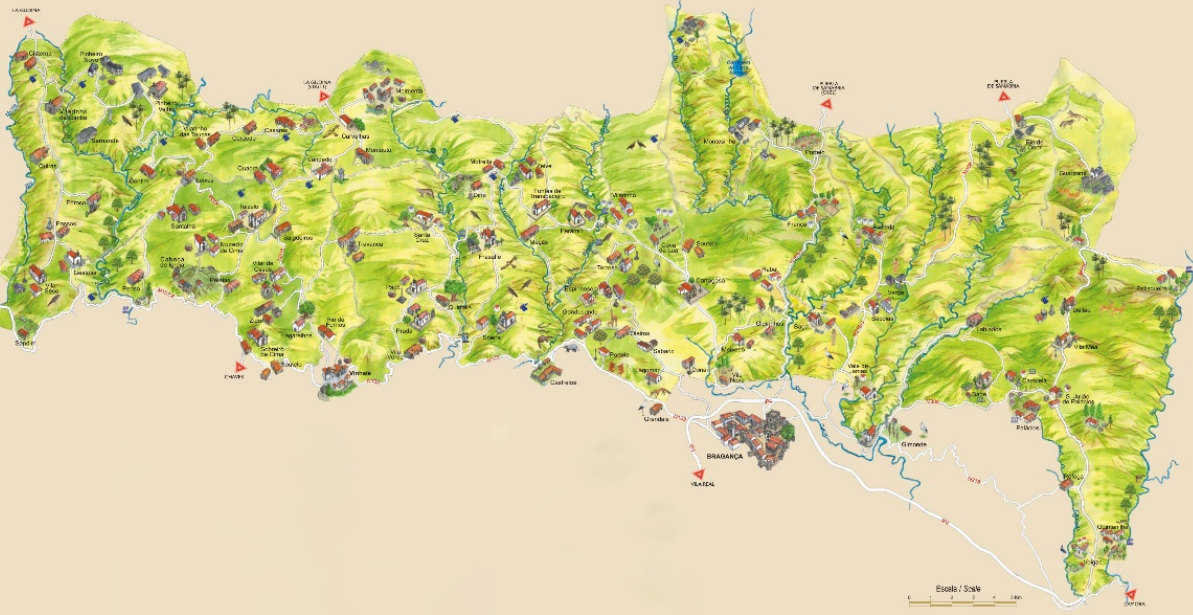
Figure 5. The map of Montesinho Natural Park.